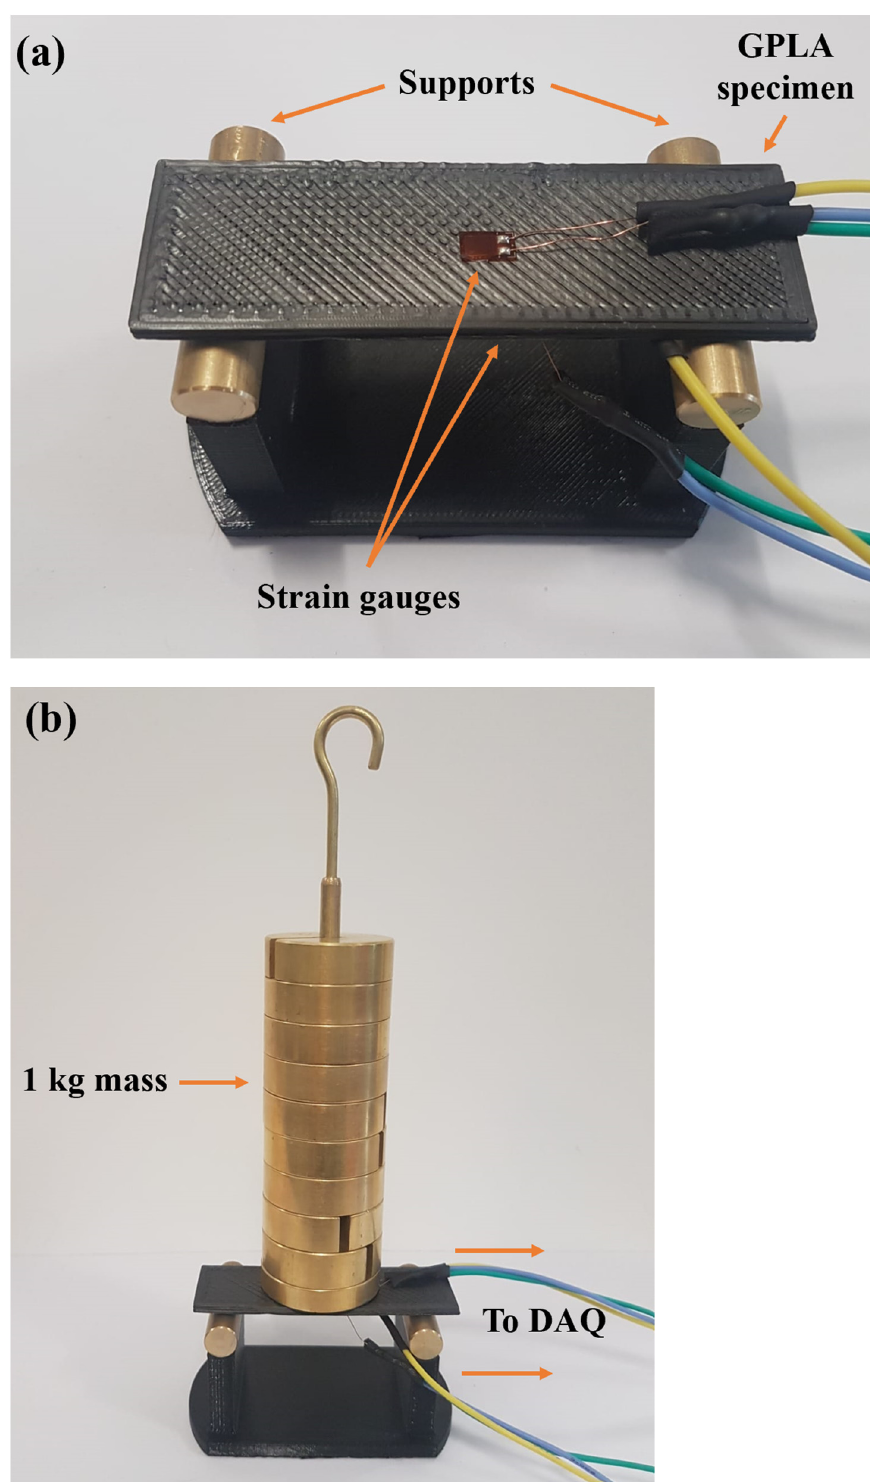
Figure 2. Strain measurement: ( a ) positioning of the strain gauges; and ( b ) placement of mass for measurements.